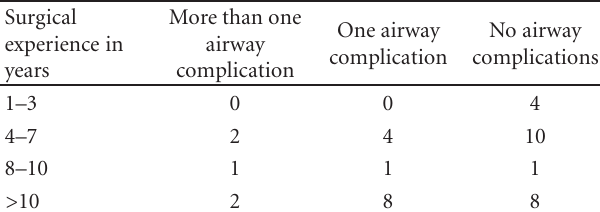
Figure 4: Bar chart representing the di ff erent causes of the airway problems. Table 1: The frequency of airway complications according to the length of surgical experience.